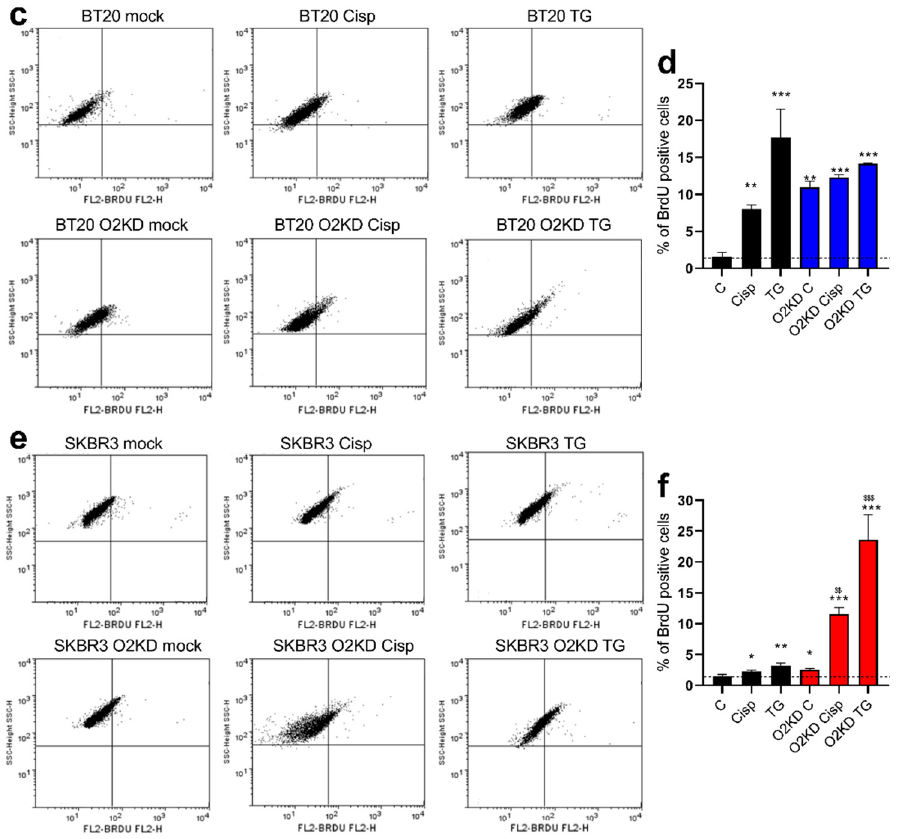
Figure 7. Orai2 is required for apoptosis resistance. T47D ( a , b ), BT20 ( c , d ) and SKBR3 ( e , f ) cells were transfected with esiOrai2 (O2KD) or non-specific siRNAscramble plasmids, as indicated. Forty- eight hours later cells were treated with cisplatin (50 µ M) for 30 min or TG (2 µ M) for 2 h, and the percentage of apoptotic cells was assessed using the in situ BrdU-Red DNA Fragmentation (TUNEL) commercial kit, as described in Section 4. Bar graphs are representative of three different experiments expressed as mean ± S.E.M. *, **, ***: represent p < 0.05, p < 0.01 and p < 0.001 as compared to cells transfected with non-specific siRNA scramble plasmids and not treated with cisplatin or TG. $$, $$$: represent p < 0.01 and p < 0.001 as compared to cells transfected with esiOrai2 but not treated with cisplatin or TG.